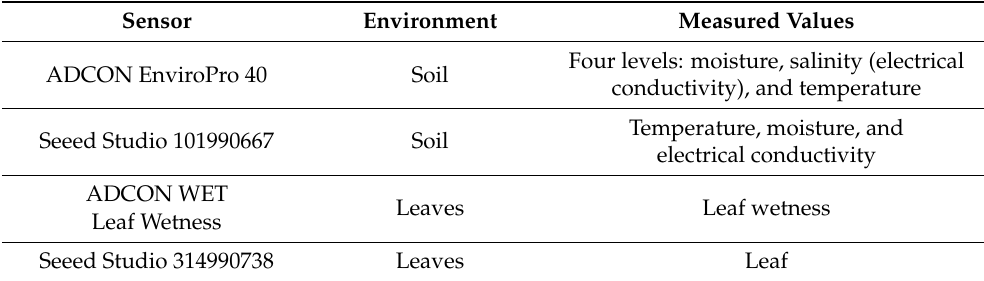
Table 1. Sensor summary and reporting